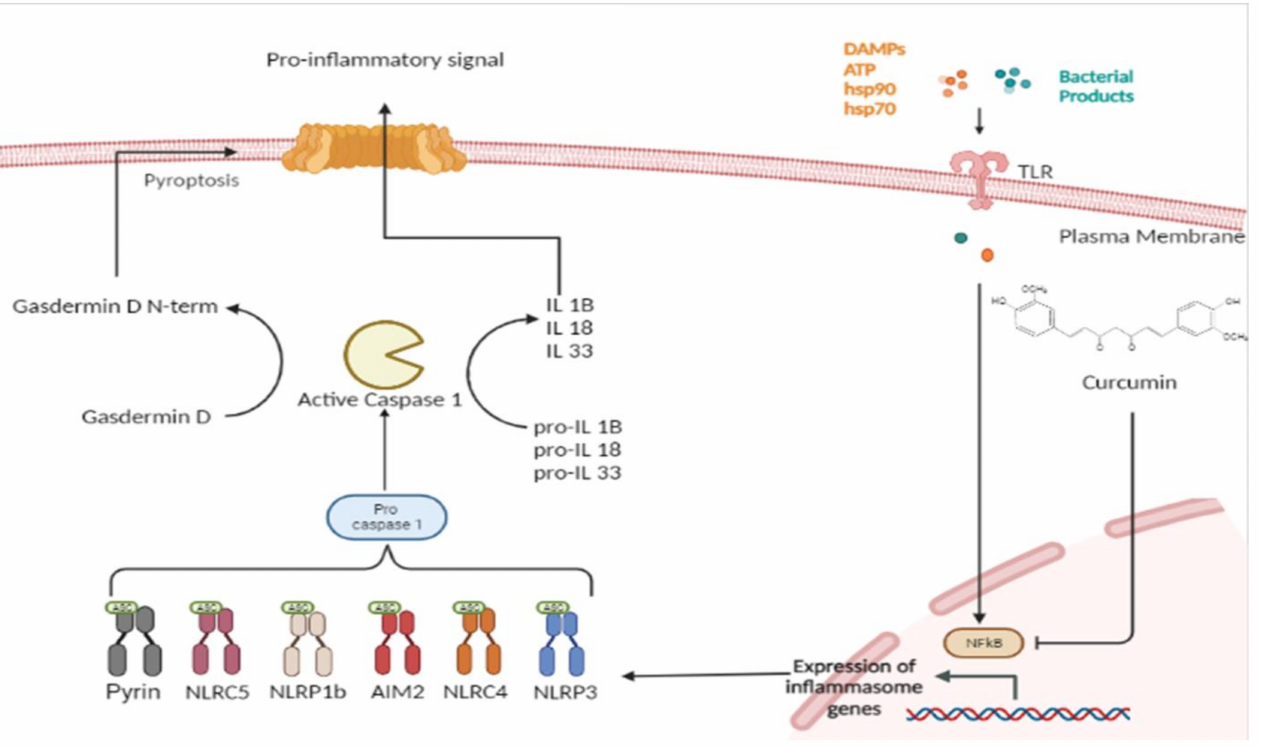
Figure 1. Curcumin inhibition of canonical